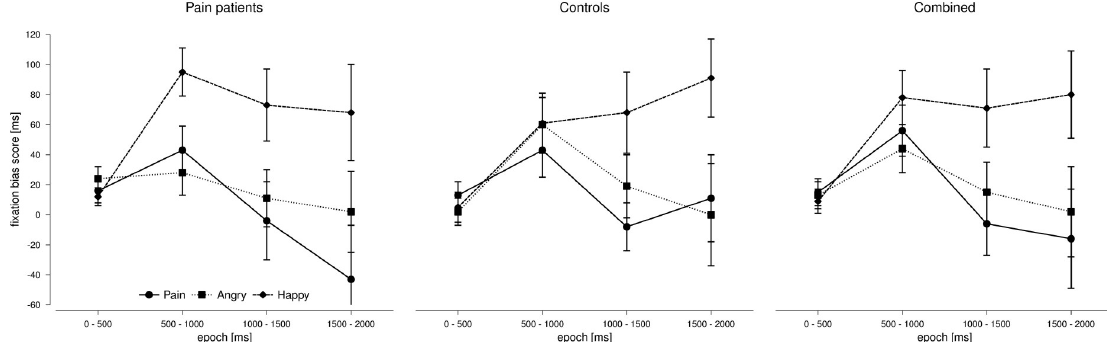
Fig 3. Means ( ± SE) of the fixation bias scores for the three emotional stimulus classes (pain, angry, and happy faces) over 4 epochs of 500ms during stimulus presentation separately for pain patients and controls and for both groups combined.